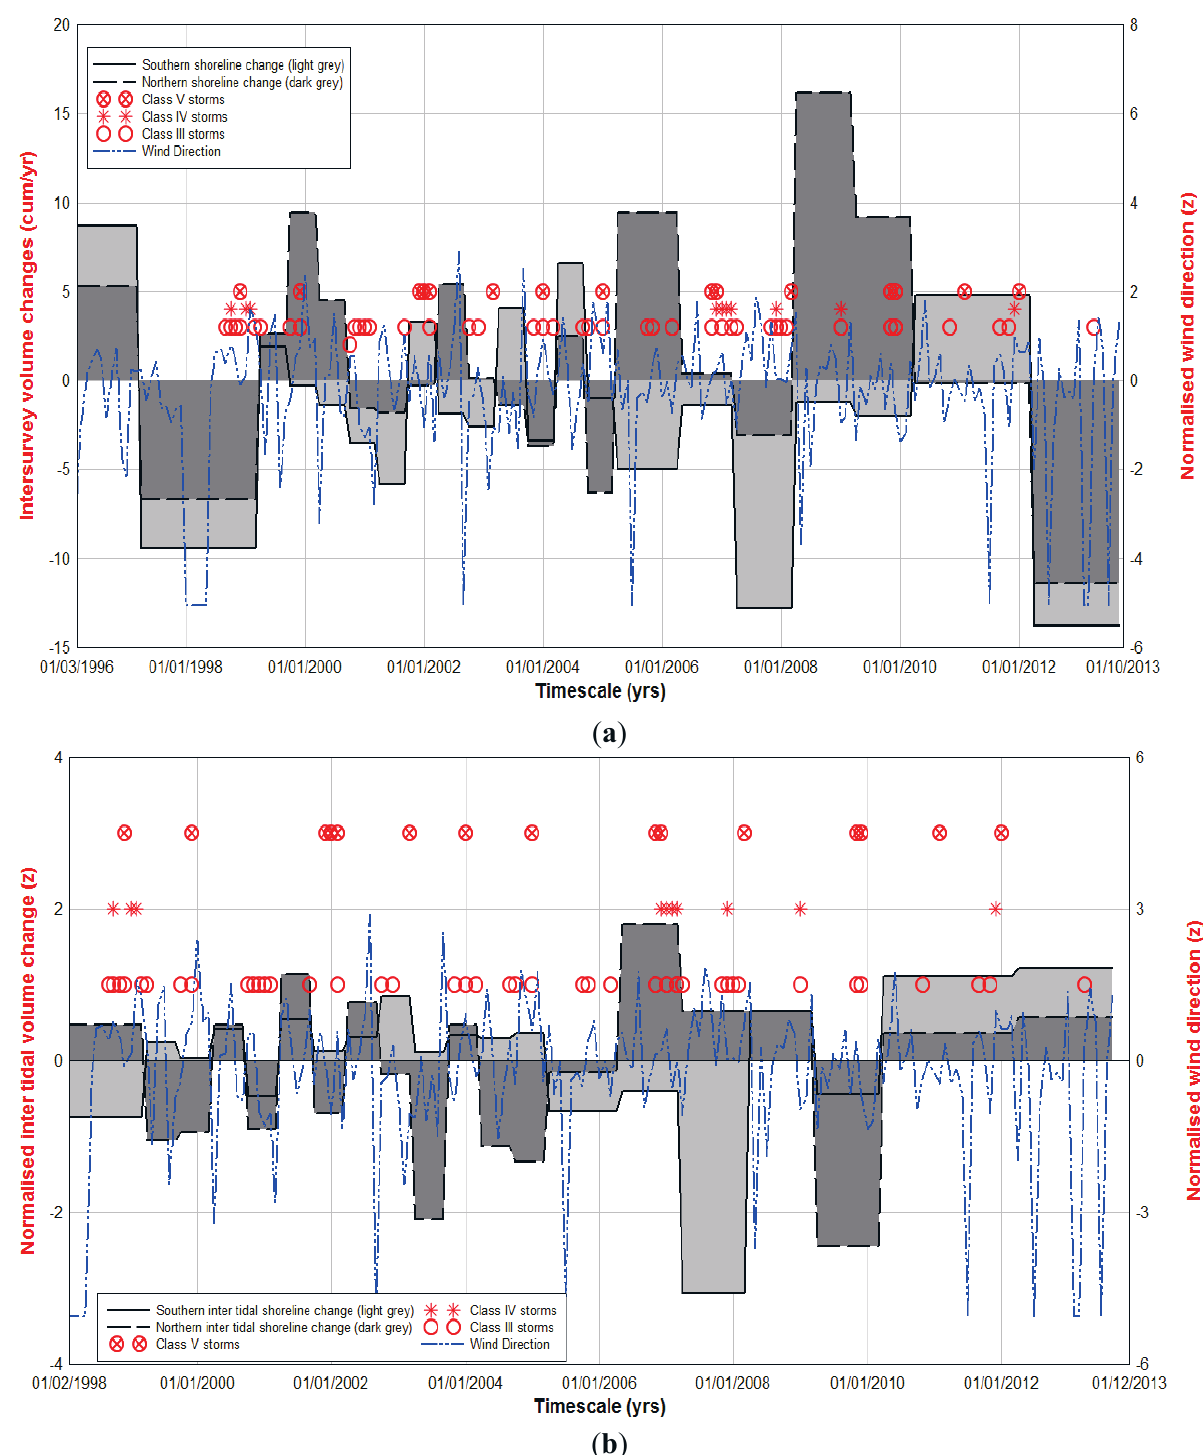
Figure 7. Graphical representations comparing normalised wind direction. Storm occurrence (class III, IV and V; 1996–2013) with: ( a ) subaerial volumes change; and ( b ) intertidal volume